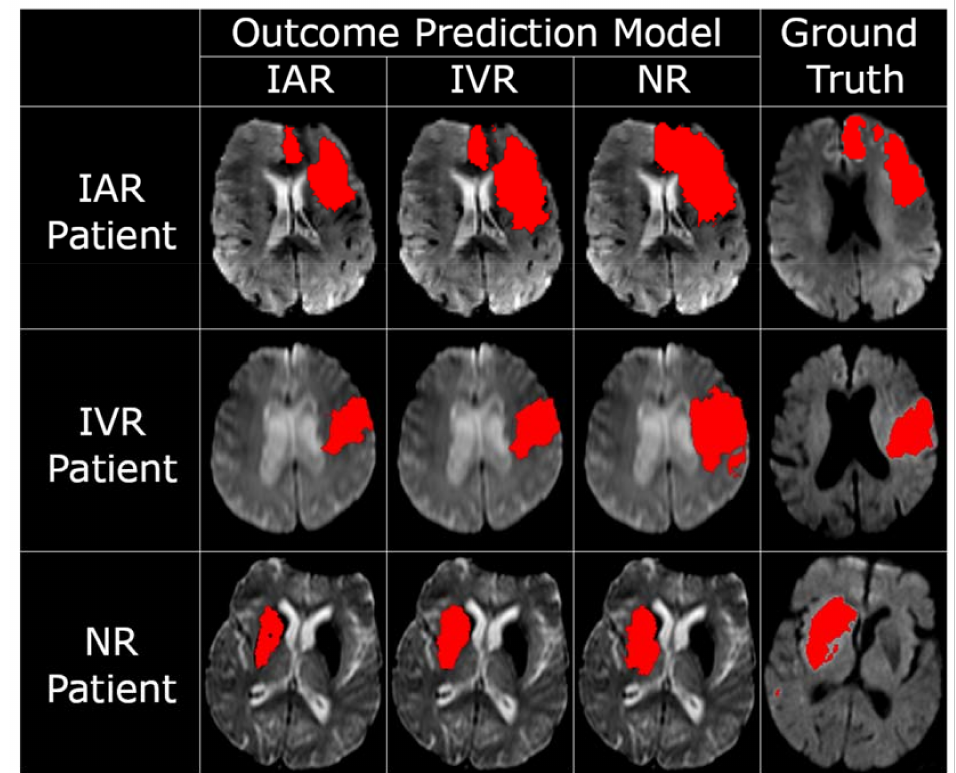
Figure 2. Selected follow-up lesion segmentations generated for each combination of outcome prediction model and patient, alongside the patients’ corresponding ground-truth follow-up lesion segmentation. Recanalization outcomes are abbreviated IAR (intra-arterial therapy, recanalizing), IVR (intravenous tPA, recanalizing), and NR